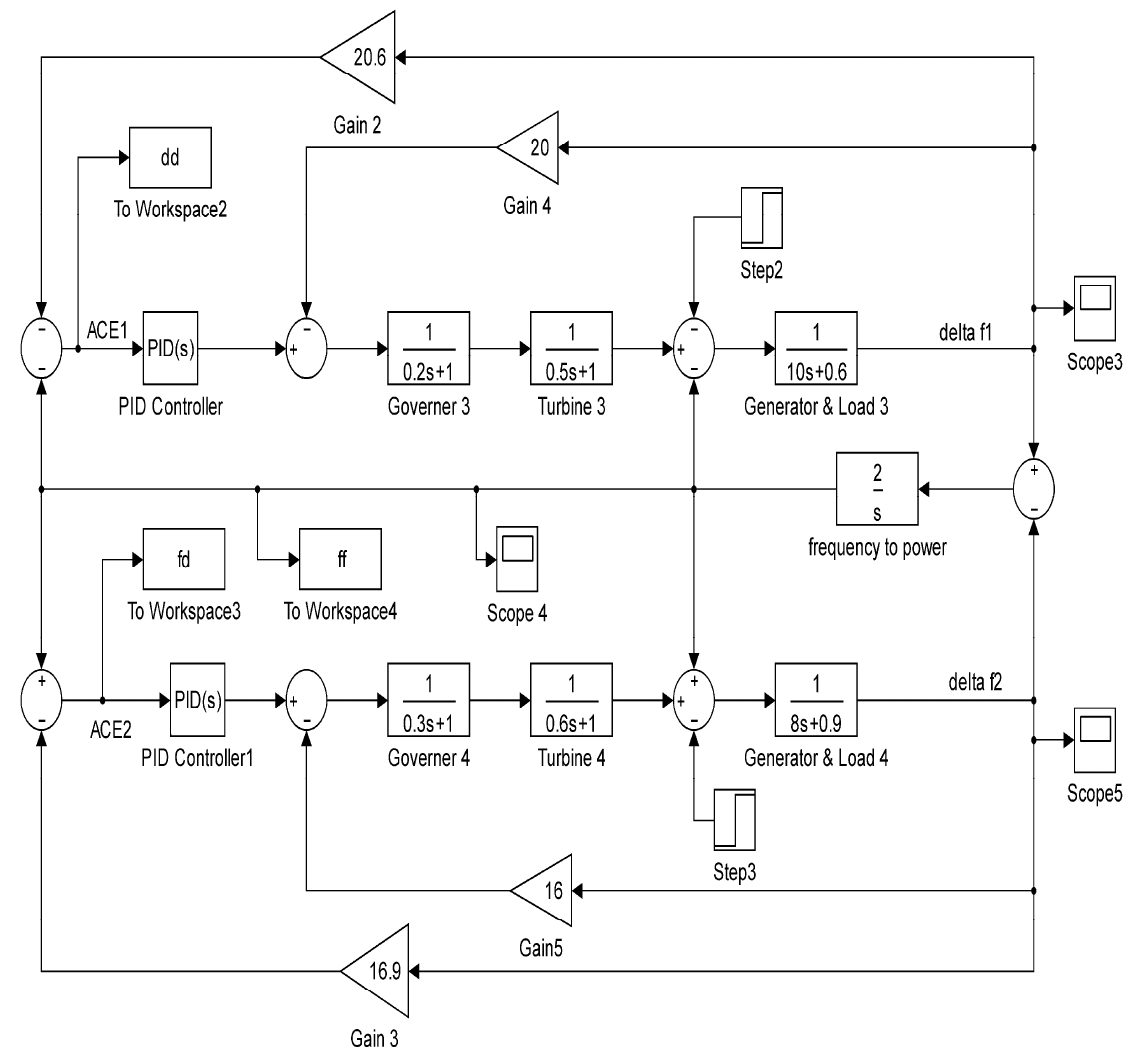
Figure 1. ( a ). Single-area AGC dynamic model and ( b ). Two-area system.